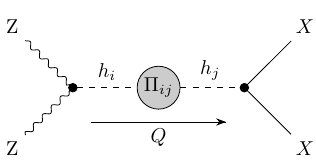
Figure 7 . The Higgs-boson mediators with their